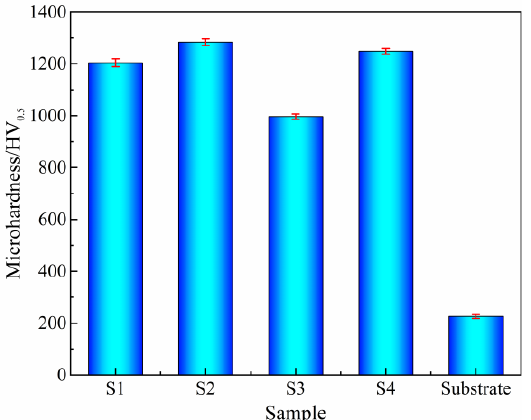
Figure 12. Microhardness of different coatings and the